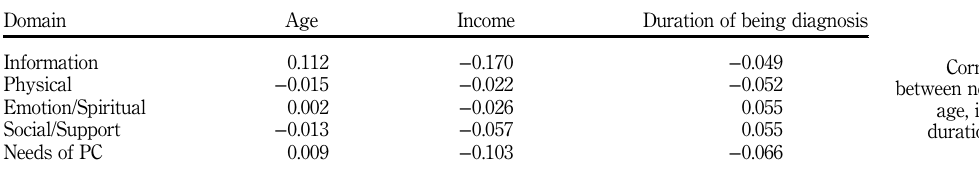
Table III. Correlations ( r